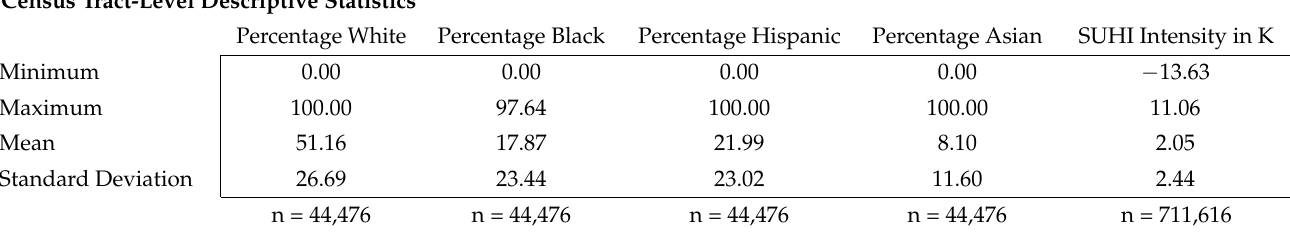
Table 1. Descriptive statistics for census tract